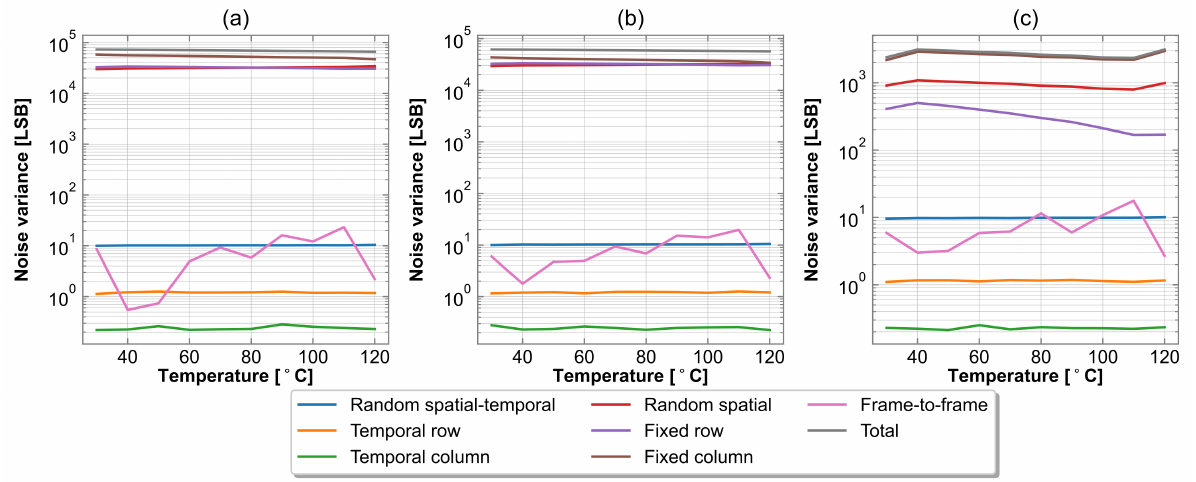
Figure 10. The 3D-noise measurements after processing steps at different blackbody temperatures. ( a ) Noise of the original image without corrections. ( b ) Results after temperature compensation. ( c ) Results after non-uniformity